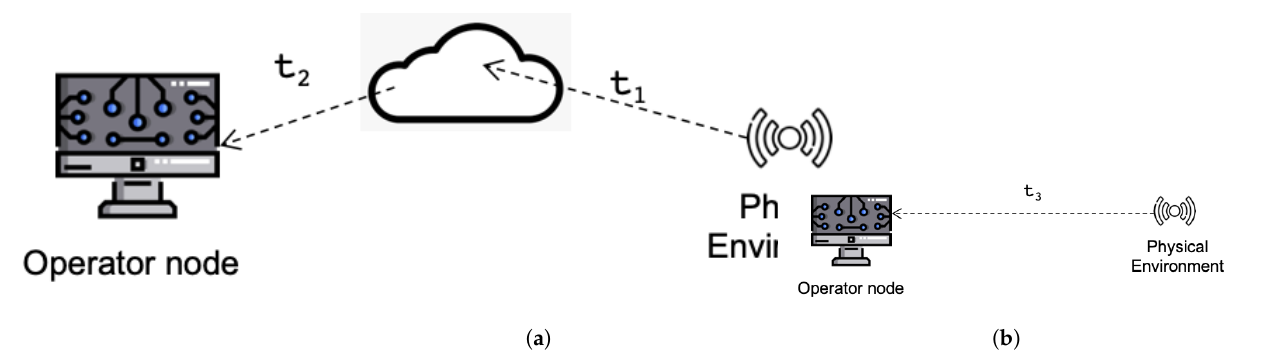
Figure 4. Communication times. ( a ) Cloud scheme. ( b ) Local scheme.